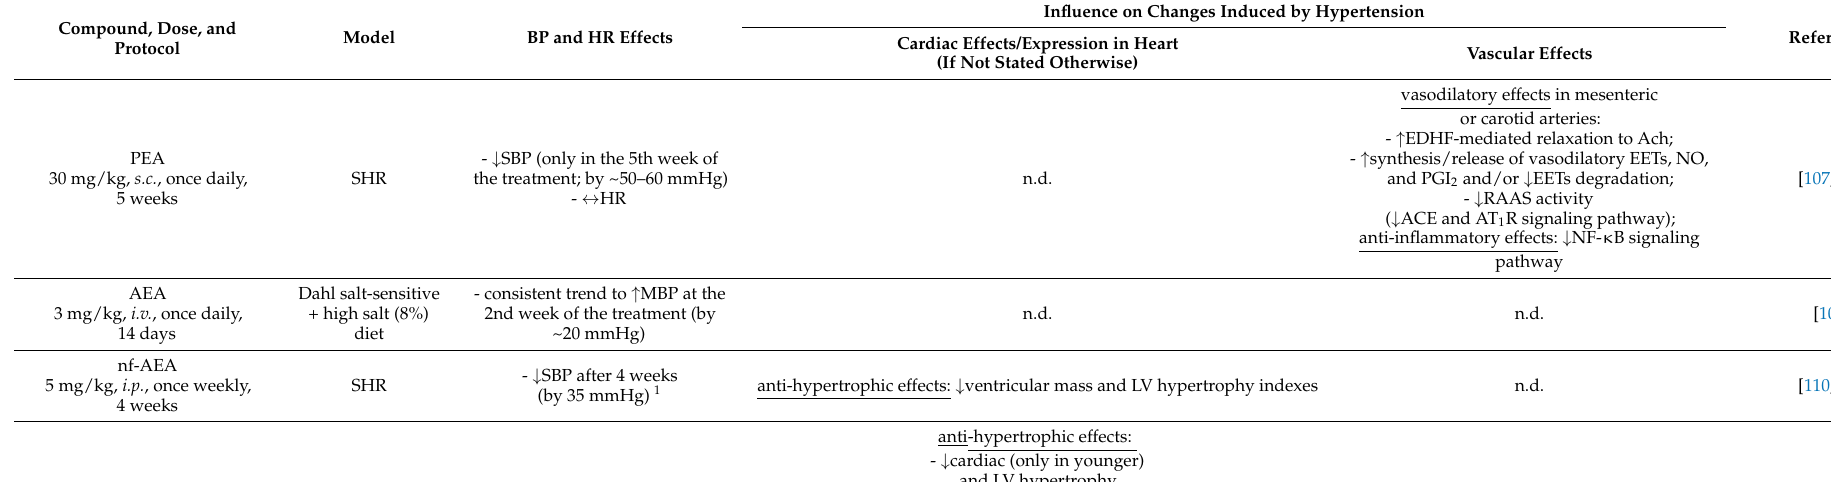
Table 3. Cardiovascular effects of chronic administration of (endo)cannabinoids in different models of systemic hypertension in male rats (unless noted